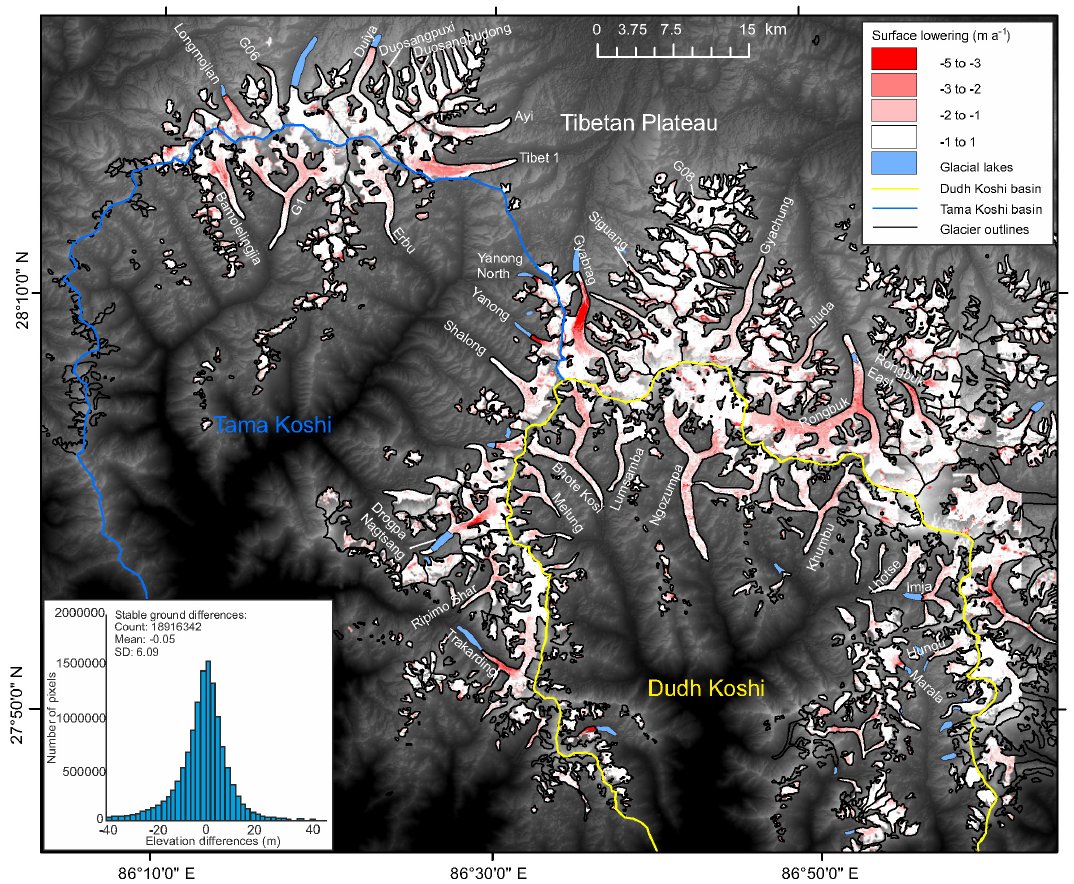
Figure 2. Glacier surface elevation change over the study area between 2000 and 2014/15. Also shown is a summary of off-glacier terrain differences. Areas of no data show the ASTER GDEM